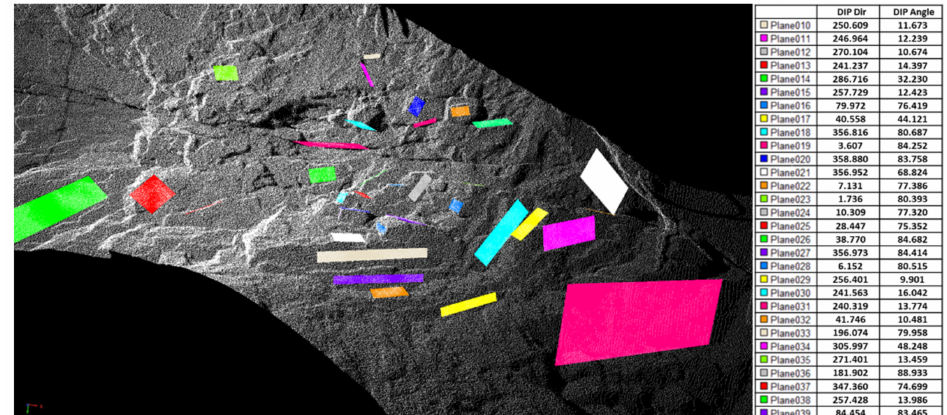
Figure 7. Identified plains on an outcrop’s portion point